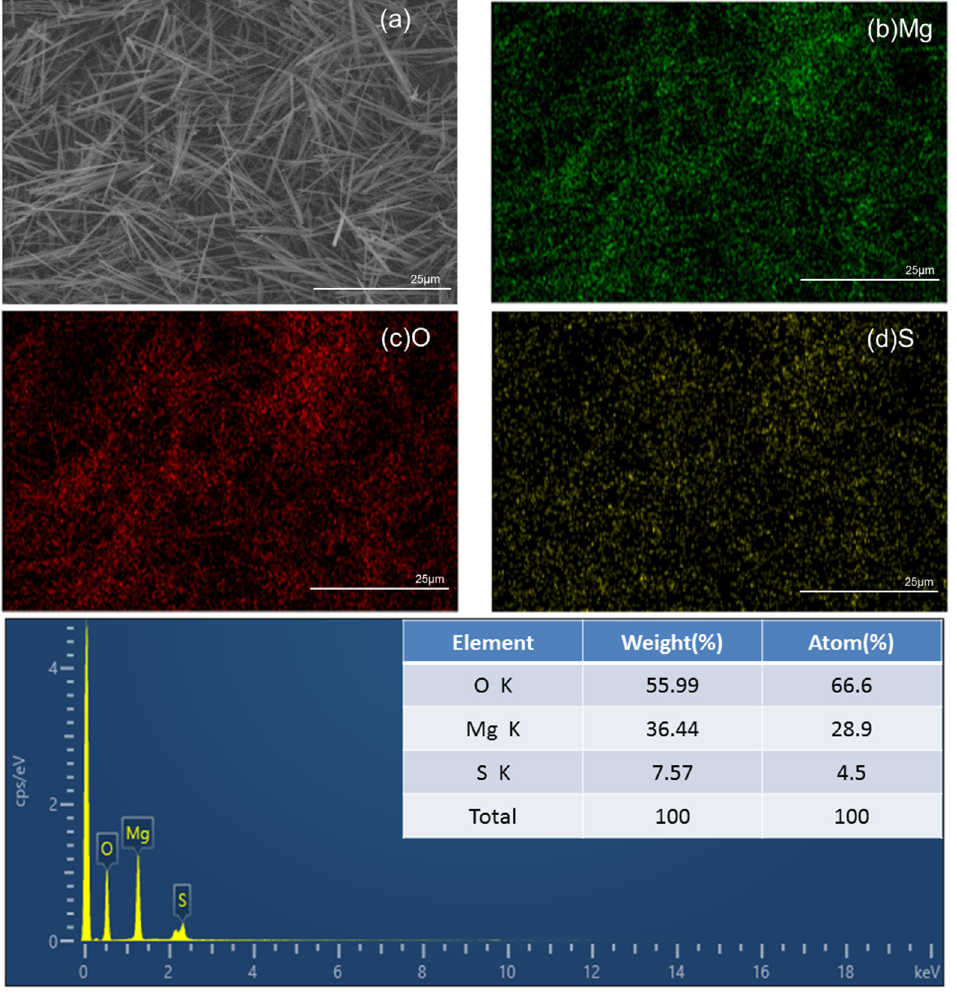
Figure 7. EDS mapping of whisker products. ( a ) is the original figure of figure ( b – d